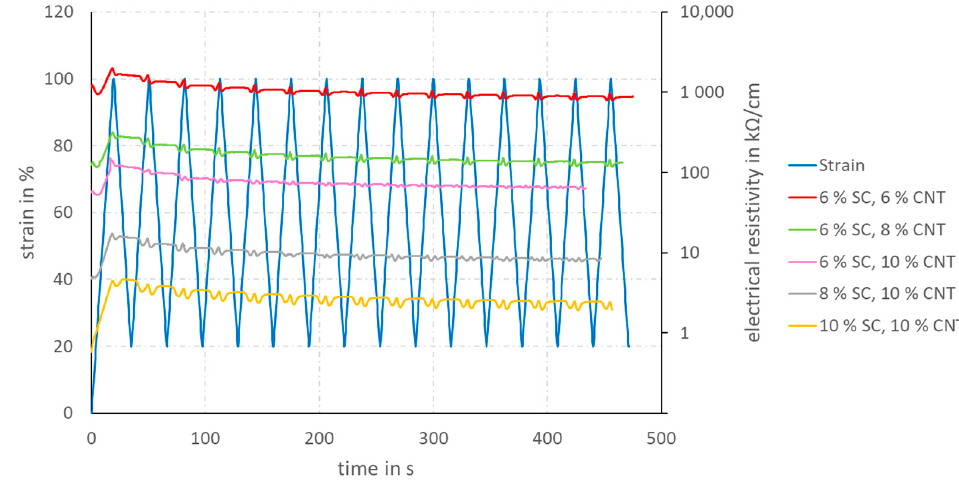
Figure 6. Cyclic-strain diagram with combined measurements of the electrical resistivity of coated TPU yarns; the light blue plot shows the mechanical strain depending on time, whereas the other plots describe the electrical resistivity, depending on time.